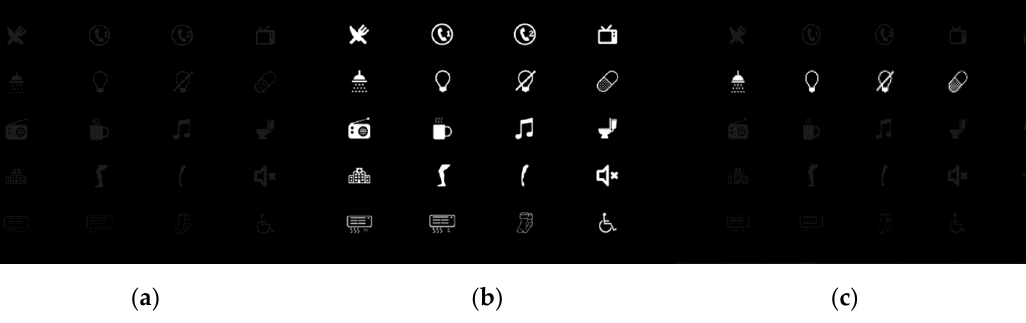
Figure 2. Healthcare function selection panel designed in this study. Each element of the matrix represent a function frequently performed in daily activities. ( a ) The panel remains dark in the switching mode; ( b ) The rows and the columns of the panel are all intensified for 3-s in the focus redirection period of the function selection mode; ( c ) The second row is being intensified during the online electroencephalography (EEG) epoch acquisition in the function selection mode.